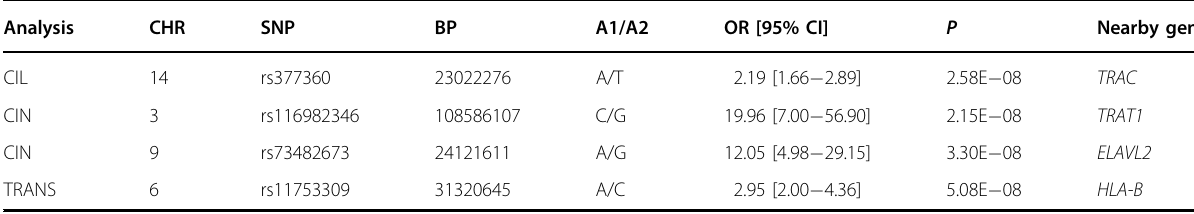
Table 1 Association results for the identi fi ed risk loci from the common variant analyses.